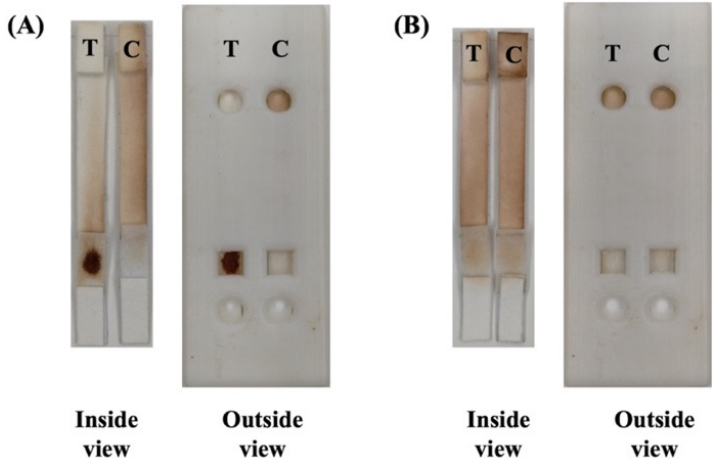
Figure 2. Inside and outside views of PAD for Mi a blood group typing ( A ) Mi a positive; ( B ) Mi a negative. Overall, the pixel intensities of SP, EP, SP: EP ratio, and F-score were significantly different between positive and negative results ( p < 0.0001) (Figure 3A, 3B, 3C and 3D, respectively). However, a positive/negative overlap was observed for the pixel intensities of SP, EP, and SP: EP ratio (Figure 3A, 3B, and 3C, respectively).